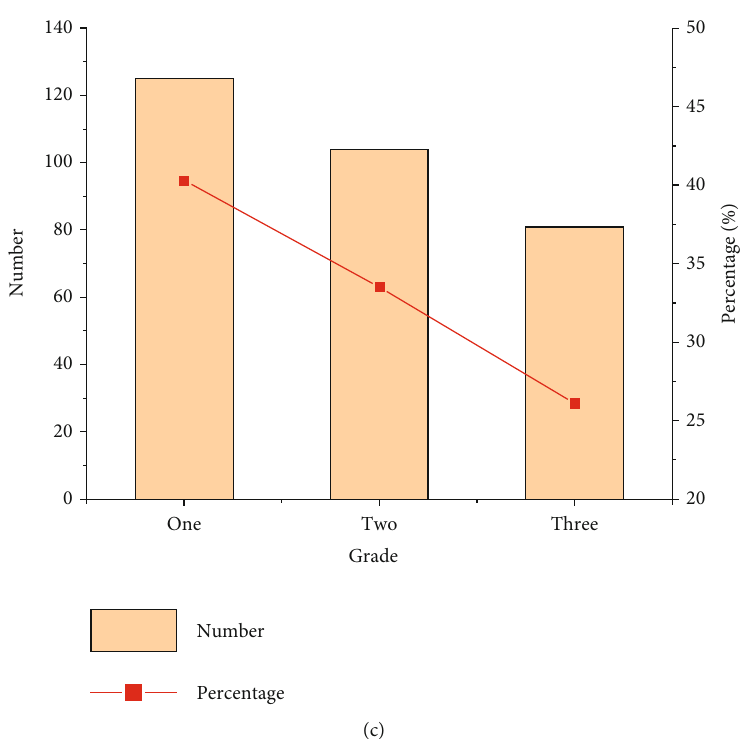
Figure 6: The composition of the test subjects. ((a) gender composition, (b) only child, and (c) grade composition).